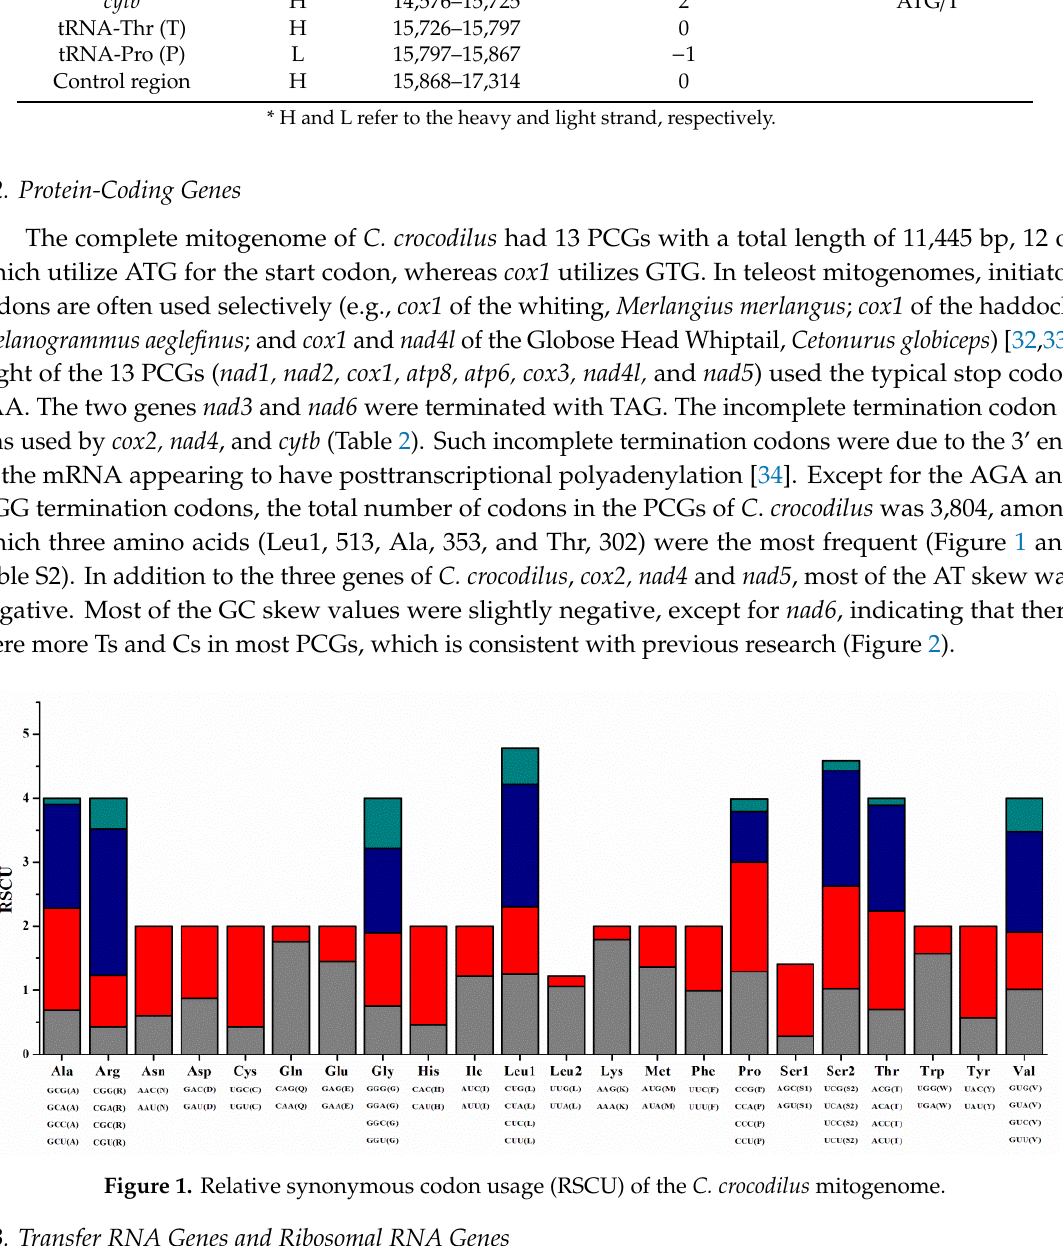
Figure 2. The AT skew and GC skew in the PCGs of the C. crocodilus mitogenome. 3.3. Transfer RNA Genes and Ribosomal RNA Genes There were 22 tRNA genes ranging from 67 bp (trnP) to 76 bp (trnL1) identified in the C. crocodilus mitogenome. Among them, 14 tRNA genes were encoded on the H-strand, and the other eight tRNA genes were coded by the L-strand (Table 2). Most of the tRNAs were folded into an ordinary cloverleaf secondary structure (Figure S2), except trnS2 (AUN), which lacked a DHU stem. This phenomenon is identical to other mitogenomes of teleost fishes, including the Scorpaeniformes species [12,35]. The standard structure of the amino acid acceptor stem was 7 bp, while trnaV, trnF, and trnaL1 (UUR) were 9 bp. Further, there were 24 base-pair mismatches present in the tRNA secondary structures, all of which formed a weak bond (G-U pairs). The compositions of the complete sequences of all 22 tRNAs showed both slightly positive AT skew (0.0136) and GC skew (0.0473), indicating that tRNAs biased toward As and Gs. The 12S and 16S rRNA genes were 1,021 bp and 1,713 bp in length, respectively, and similarly, the AT skew (0.0763 and 0.2227) was slightly positive and the GC skew ( − 0.1952 and − 0.1064) was negative. They were situated between trnF and trnL1 and there is a trnV between rRNAs similar to other vertebrate mitogenomes to date [36–38]. 3.4. Noncoding Regions There were two long noncoding regions in the mitogenome of C. crocodilus , O L and CR, which were closely related to the initiation of the replication and transcription of the mitogenome [39,40]. Located between trnN and trnC with a length of 30 bp, the relatively short gene O L was folded into a hairpin secondary structure (Figure S3). The CR was the longest noncoding region and extended over 1447 bp between trnP and trnF, with a 68.76% A + T content, which is the highest among Scorpaeniformes species to date. Similarly to other teleost fish, there were several conserved